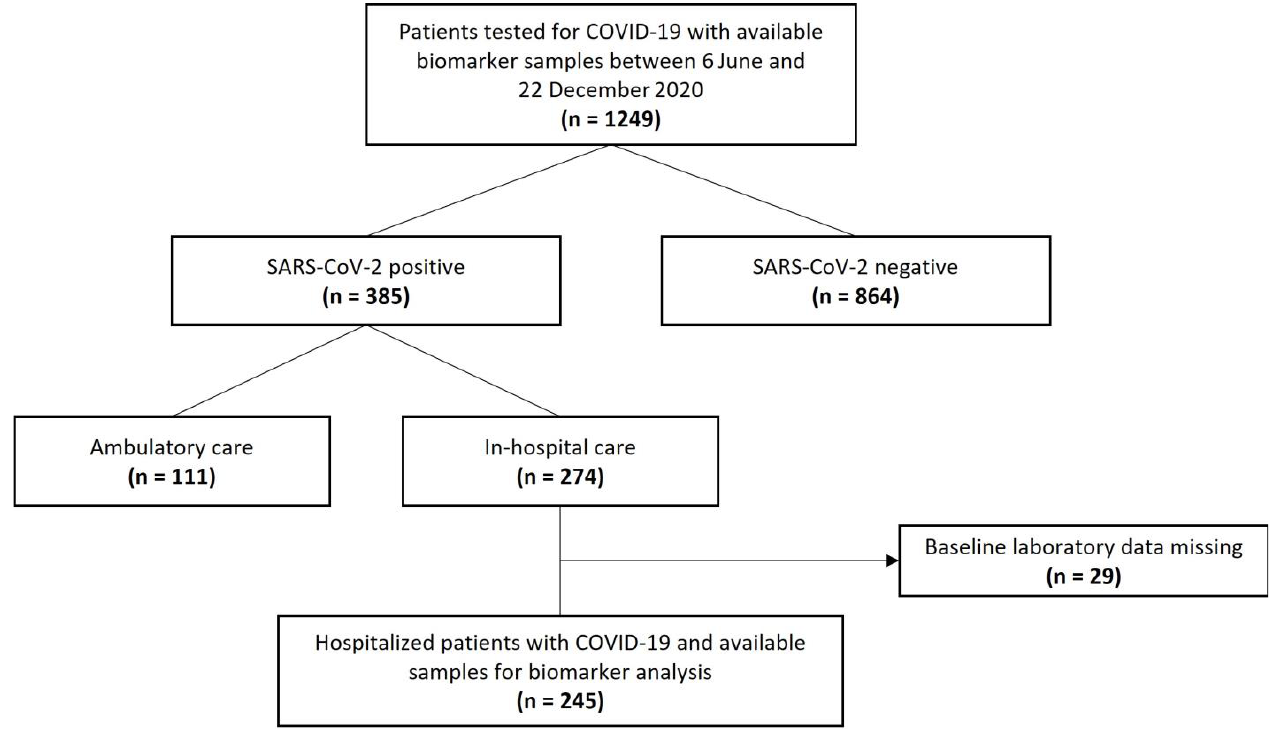
Figure 1. Study flow chart.